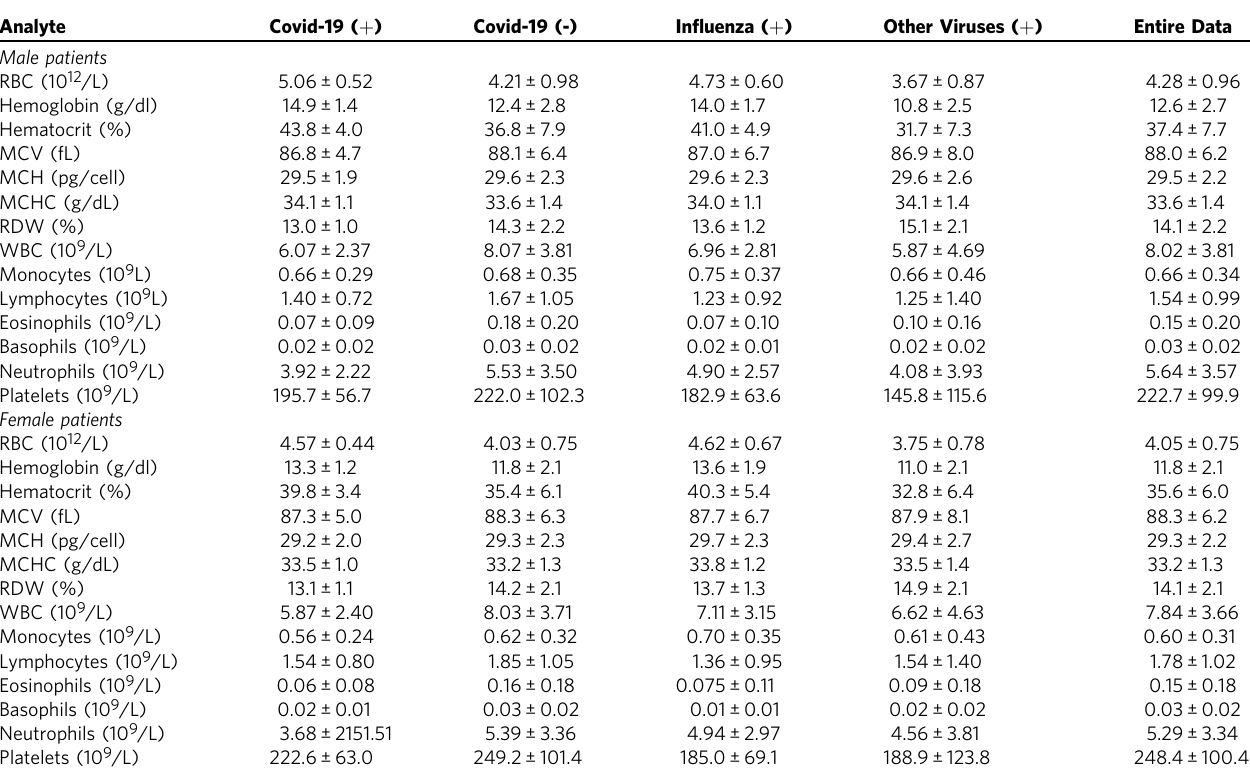
Table 1 Mean and standard deviation for all considered cell counts in each cohort. N = 1,138,728 CBCs. Analyte Covid-19 ( +